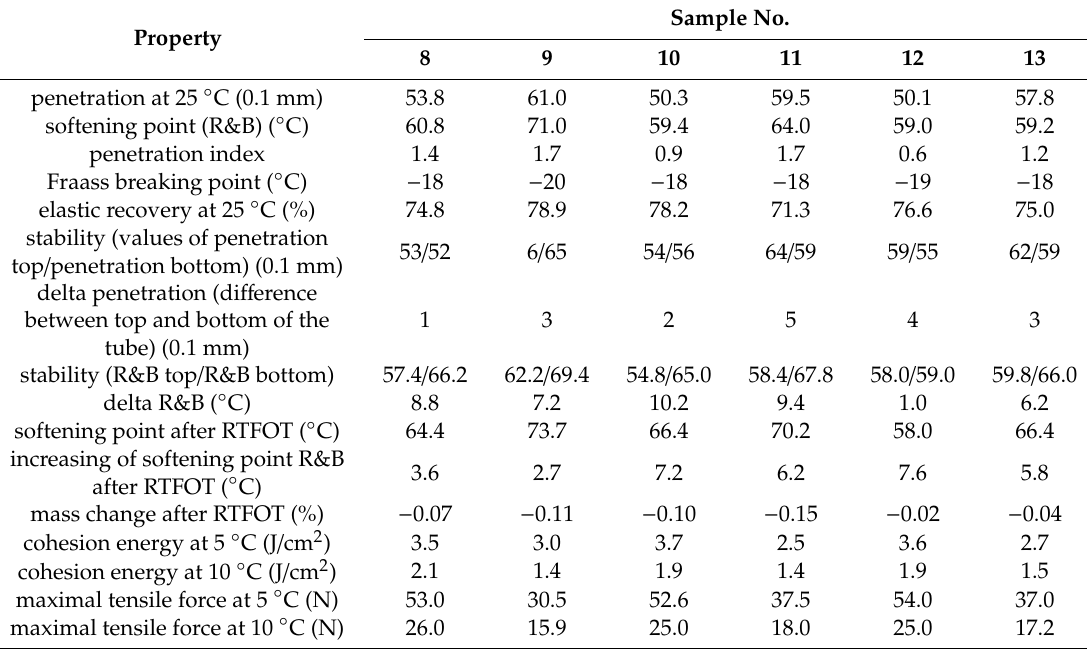
Table 4. Properties of bitumen modified at 220 ◦